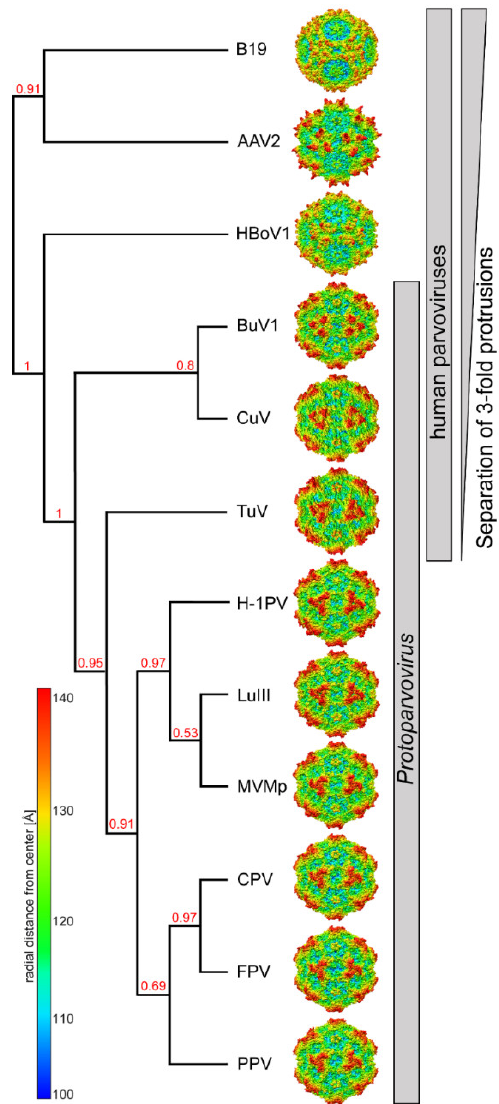
Figure 5. Cladogram showing the capsid amino acid and structural relationship between the protoparvoviruses and selected members of human parvoviruses. B19: parvovirus B19; AAV: adeno-associated virus; HBoV: human bocavirus. This image was generated online (http://www.phylogeny.fr/) utilizing the VP2/3 sequences as input. Branch support values are given. Radially-colored capsid surface representations (blue to red, as shown in the scale bar on the left) are viewed along the 2-fold axis and generated using Chimera [27].